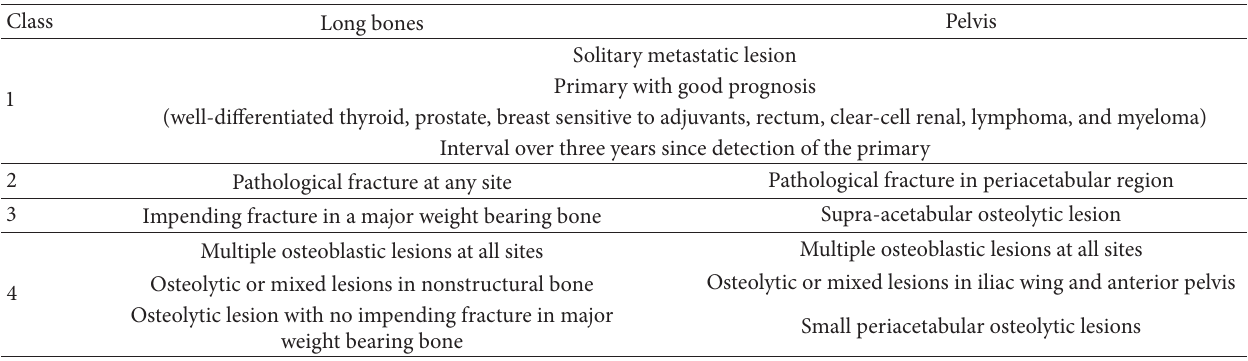
Figure 2: Indications for surgical and conservative treatment according to the patient classes. Table 1: Characteristics of the different patient classes comparing metastatic lesions in long bones and